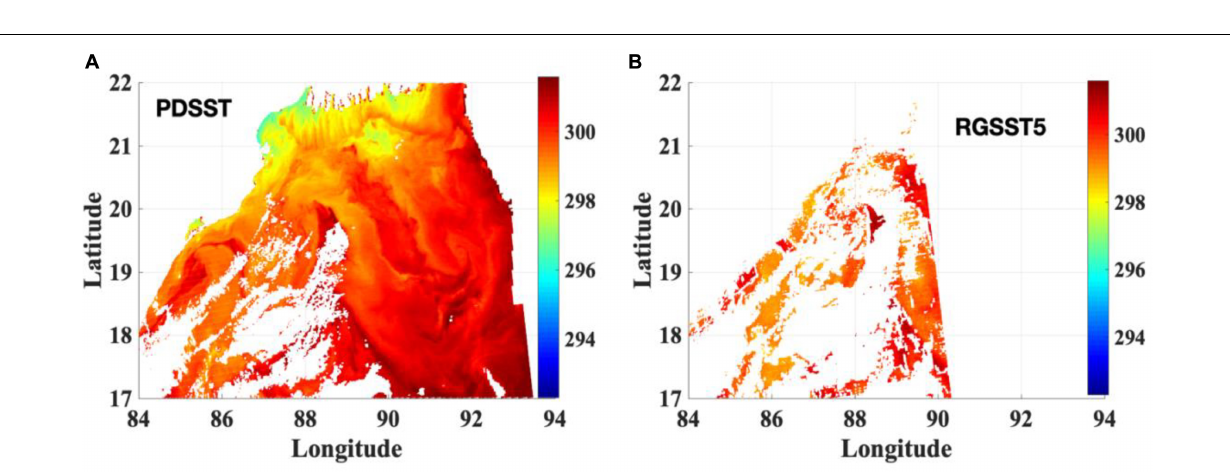
FIGURE 6 | Comparison of daytime SST retrieval maps of a subset of area 10 ◦ by 5 ◦ from a granule of MODIS-AQUA for Bay of Bengal: (A) PDSST and (B) RGSST5. The ranges of longitude and latitude from − 180 ◦ to 180 ◦ and from − 90 ◦ to 90 ◦ represent West to East and South to North, respectively. Unit of color bar is